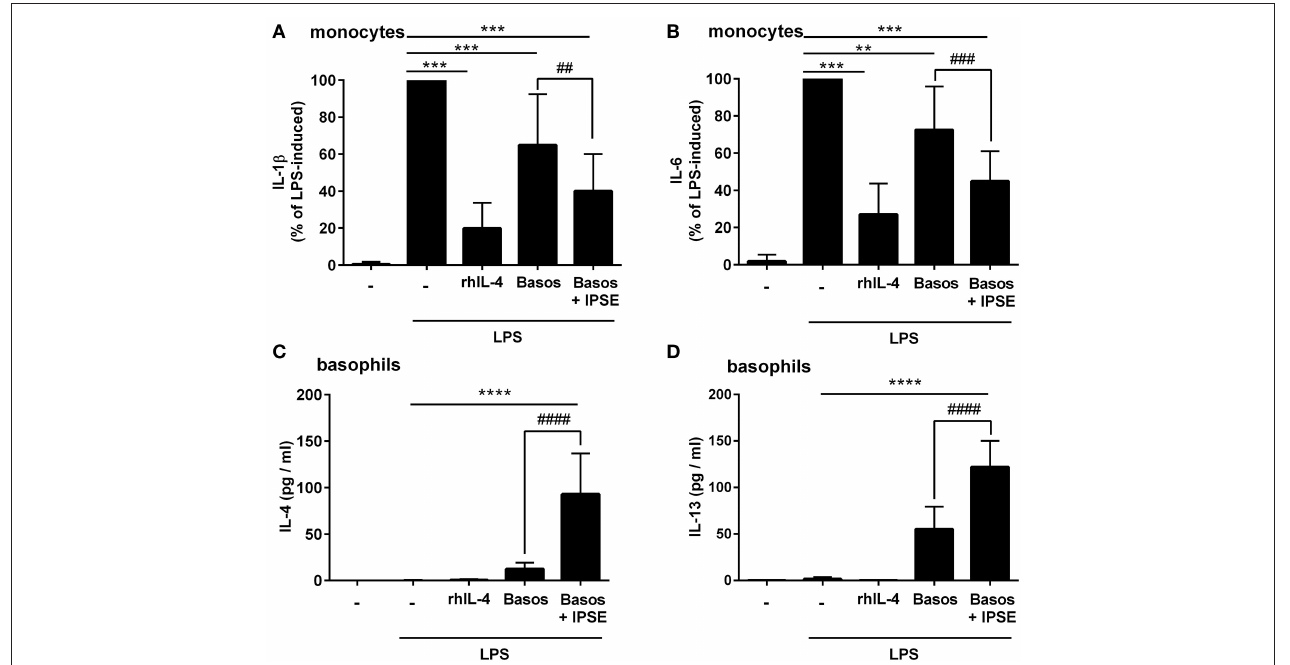
FIGURE 1 | IPSE/alpha-1-triggered basophil IL-4 inhibited the release of IL-1 β and IL-6 from human LPS-activated monocytes. Release of IL-1 β (A) and IL-6 (B) from monocytes, and IL-4 (C) and IL-13 (D) from basophils. Monocyte-derived cytokine release (A,B) was normalized to the maximum release following LPS activation (100%). Note, rhIL-4 was only very poorly detected by the IL-4 ELISA (Diaclone), because the monoclonal antibodies in this ELISA are directed against natural IL-4 and do not bind properly to the recombinant IL-4. Data are presented as mean ± SEM, IL-1 β and IL-6: n = 14; IL-4: n = 13; IL-13: n = 11. Statistics were performed with the Wilcoxon matched-pairs signed rank test (A,B) or paired t -test (C,D) ; * = significance “LPS + additions (IL-4, basophils, basophils + IPSE)” vs. “LPS without additions”; ** p < 0.01, *** p < 0.001, **** p < 0.0001; # = significance “basophils with IPSE/alpha-1” vs. “without IPSE/alpha-1”; ## p < 0.01, ### p < 0.001, #### p < 0.0001.